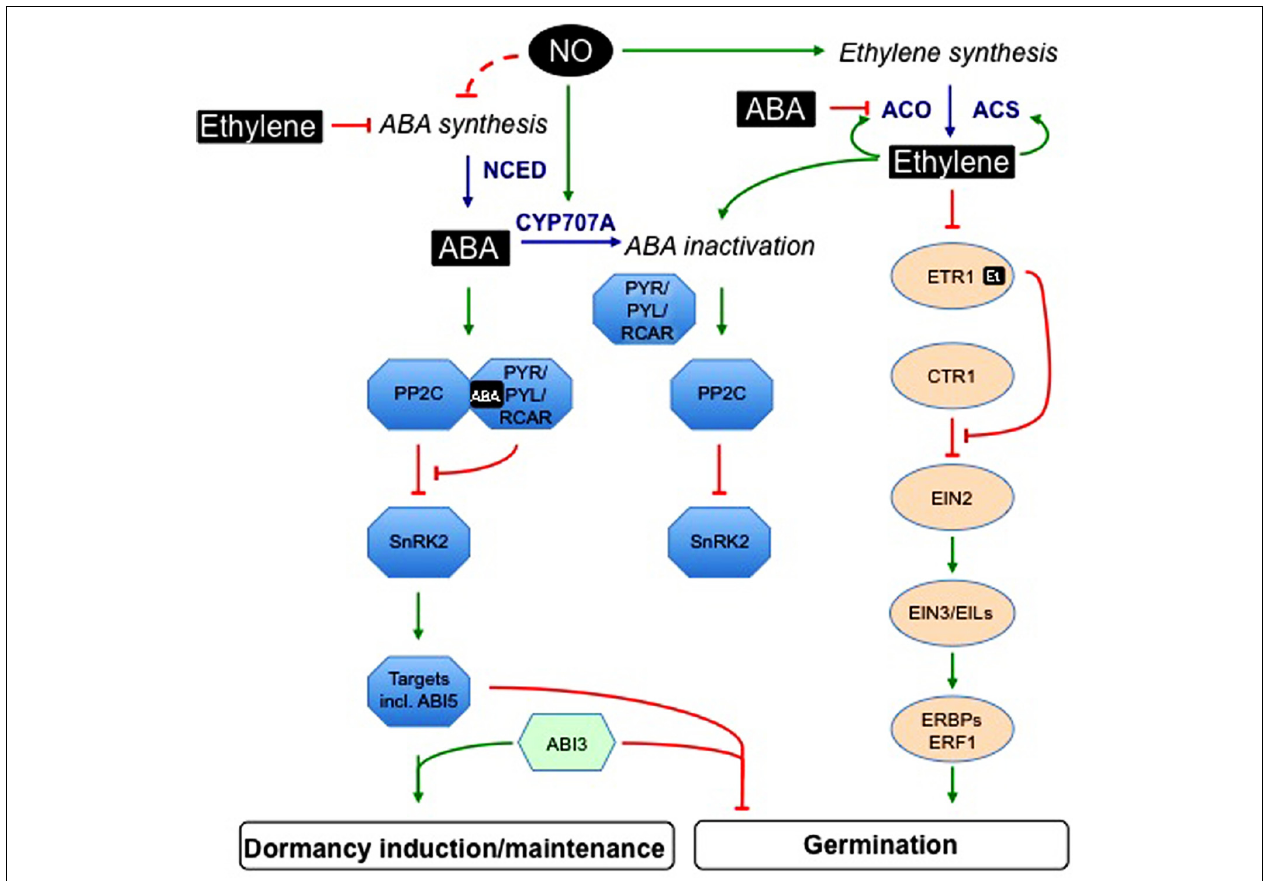
FIGURE 2 | Interactions between ethylene, abscisic acid, and nitric oxide signaling pathways in the regulation of seed germination and dormancy. This scheme is based on genetic analyses, microarray data, and physiological studies on seed responsiveness to ABA, ethylene, or NO. ABA binding to PYR/PYL/RCAR receptor induces the formation of a protein complex with PP2C and the inhibition of phosphatase activity. In the absence of ABA, PP2C dephosphorylate SnRK2.When ABA is present, PP2C binding to the receptor releases inhibition of SnRK2 activity, which can phosphorylate downstream targets, including ABI5-related transcription factors. Interactions between ABI3 and ABI5 mediate transcriptional regulation of ABA-responsive genes. Ethylene positively regulates its own biosynthesis, by acting on ACC synthesis catalyzed by ACS and subsequent conversion to ethylene by ACO. This last step is also subject to ABA inhibition. Ethylene is perceived by receptors (among which ETR1) located in the endoplasmic reticulum; its binding leads to the deactivation of the receptors that become enable to recruit CTR1. Release of CTR1 inhibition allows EIN2 to act as a